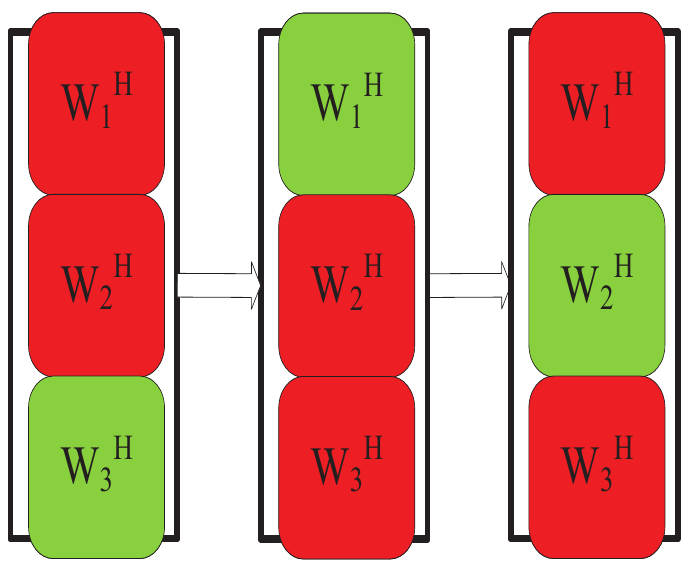
Figure 7. IP-2 update